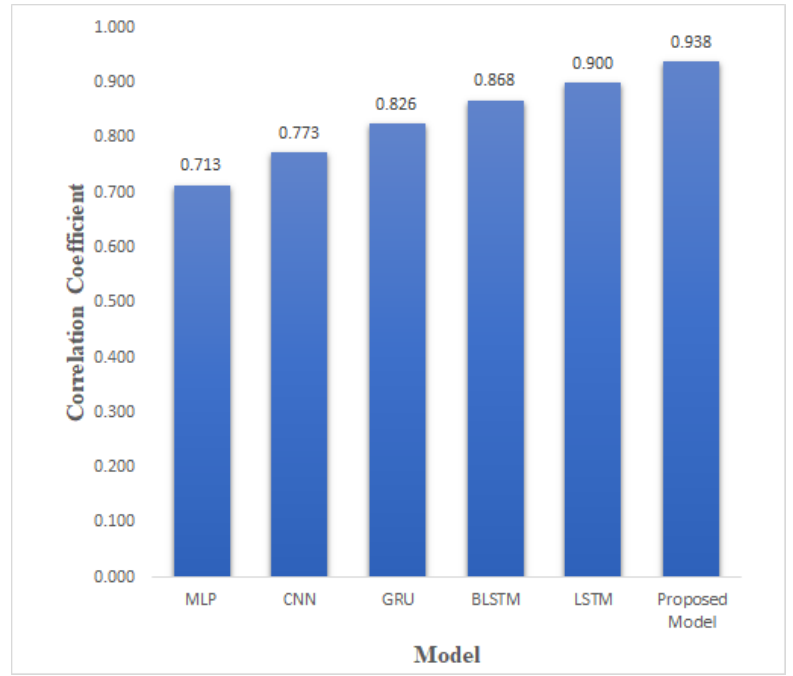
Figure 9. Pearson Correlation Coefficient values of 5 existing deep learning models and our proposed model. The score of the proposed model was the highest among the